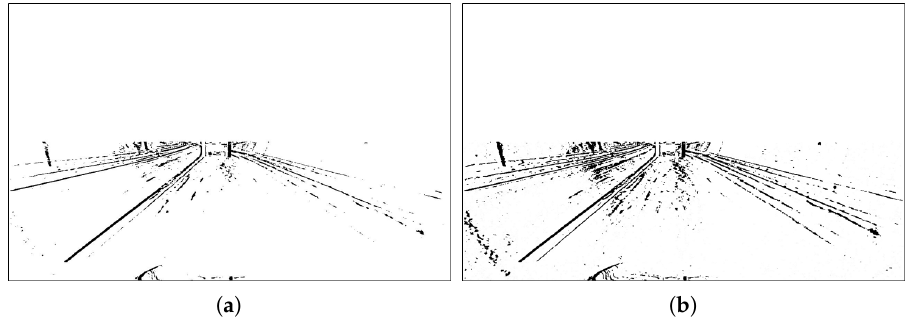
Figure 11. Edge detection results: ( a ) result ( Th E = Th H ), and ( b ) result ( Th E = Th L